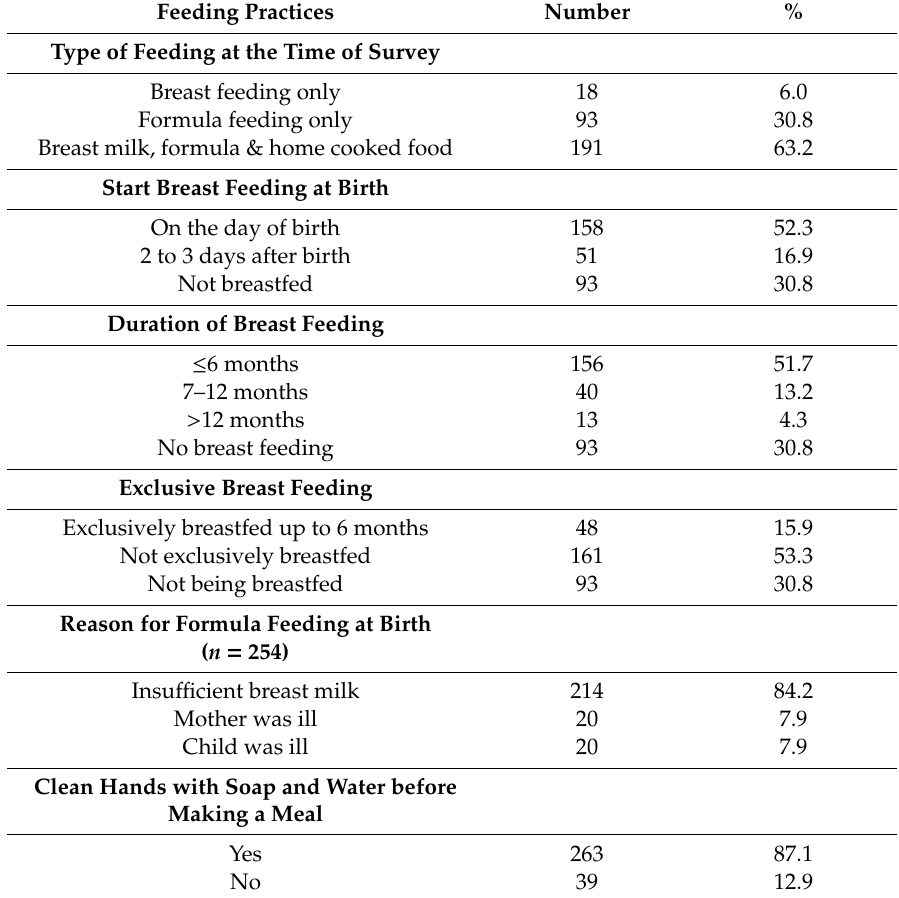
Table 2. Feeding Practices of the